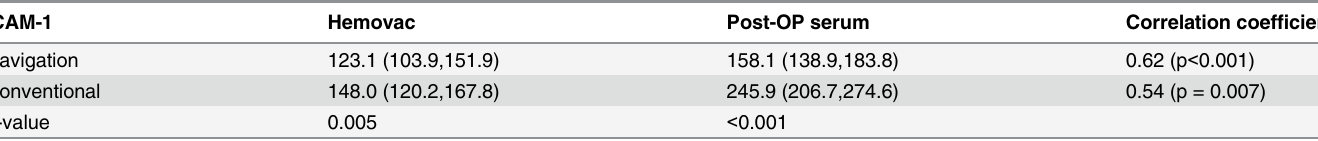
Table 5. Correlation of ICAM-1 concentrations (unit: ng/mL) in hemovac samples and postoperative serum samples.